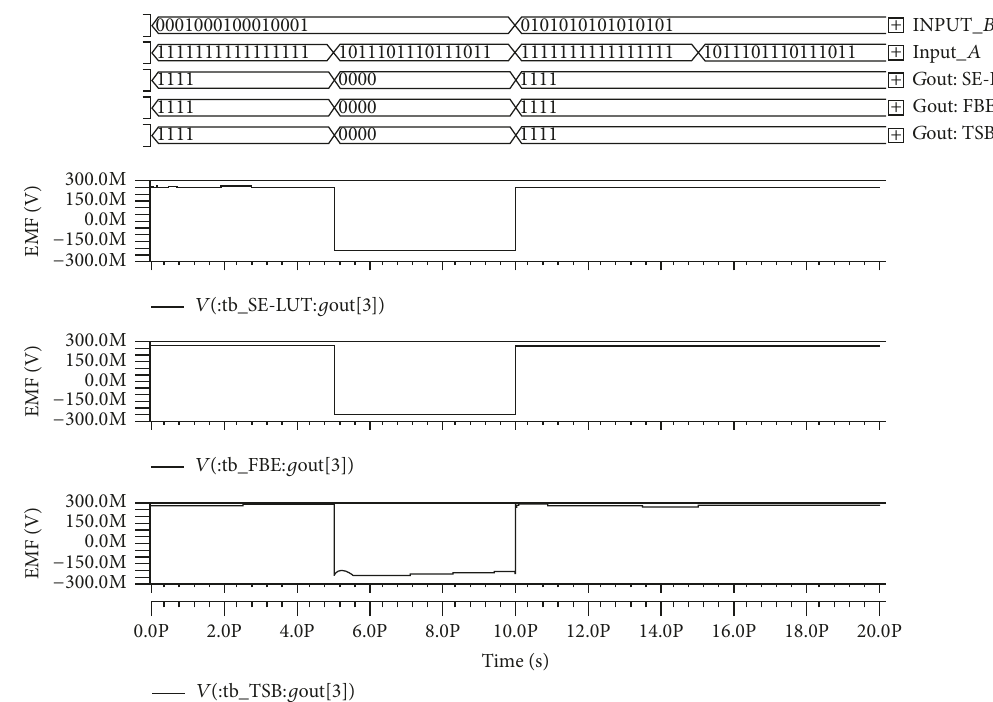
Figure 18: Output waveforms for the sparse tree adder.